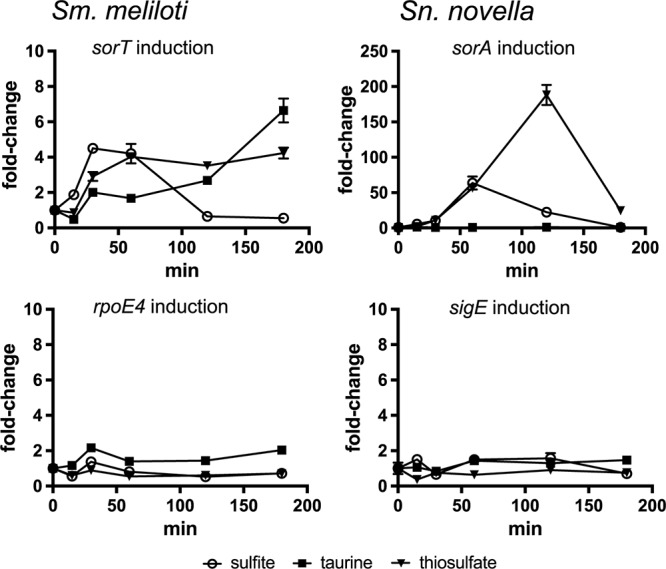
Fold-change in SOE and ECF sigma factor gene expression following exposure to sulfite, taurine and thiosulfate in Sm. meliloti 1021 and St. novella 506T. Left:
Sm. meliloti gene expression induction, Top: induction of the sorT SOE gene, Bottom: induction of the rpoE4 ECF sigma factor gene. Right:
St. novella gene expression induction, Top: induction of the sorA SOE gene, Bottom: induction of the rpoE4 ECF sigma factor gene. Data are shown as the average and standard deviation of at least three assays. The underlying gene expression data is shown in Supplementary Figure S3. 2-Way ANOVA of changes in rel. normalized gene expression compared to the t = 0 value showed that for sulfite addition changes were statistically significant (alpha = 0.05) from t = 15 min (Sm) and t = 30 min (Sn) with p = 0.0032 (∗∗) (Sn, 30 min) to p < 0.0001 (∗∗∗∗) for all other values, for thiosulfate addition from t = 30 min (Sm) and t = 60 min (Sn) with p < 0.0001 (∗∗∗∗) for all datapoints, for taurine all values were not significant except Sm 120 min, p = 0.0232 (∗), and 180 min (p < 0.0001, ∗∗∗∗). For clarity the p-values are not shown in the figure.